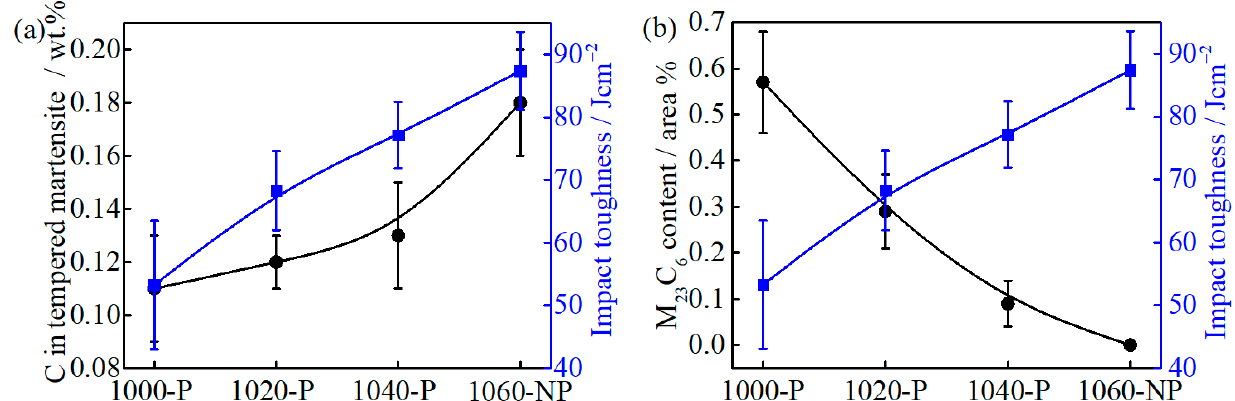
Figure 14. The relationship between ( a ) tempered martensite carbon content and impact toughness; and ( b ) M 23 C 6 area fraction and impact toughness.